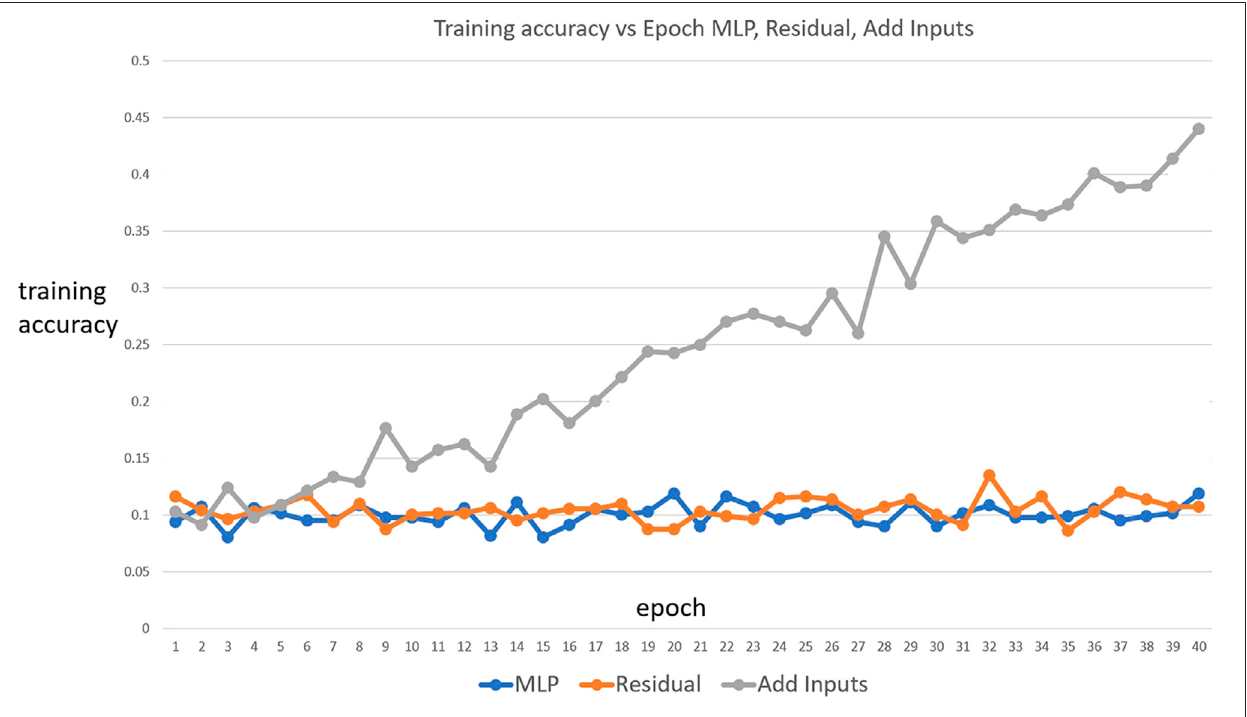
FIGURE6| Fittingamultilayerperceptron,anadd-shortcuts,andanadd-inputsnetworktorandomnoiseimageswithtenarbitraryclasses.Theadd-inputsmodel is able to fi t the noise images while the other two models are not able to. Accordingly, this NN has more fl exibility than the other networks, and can over fi t.